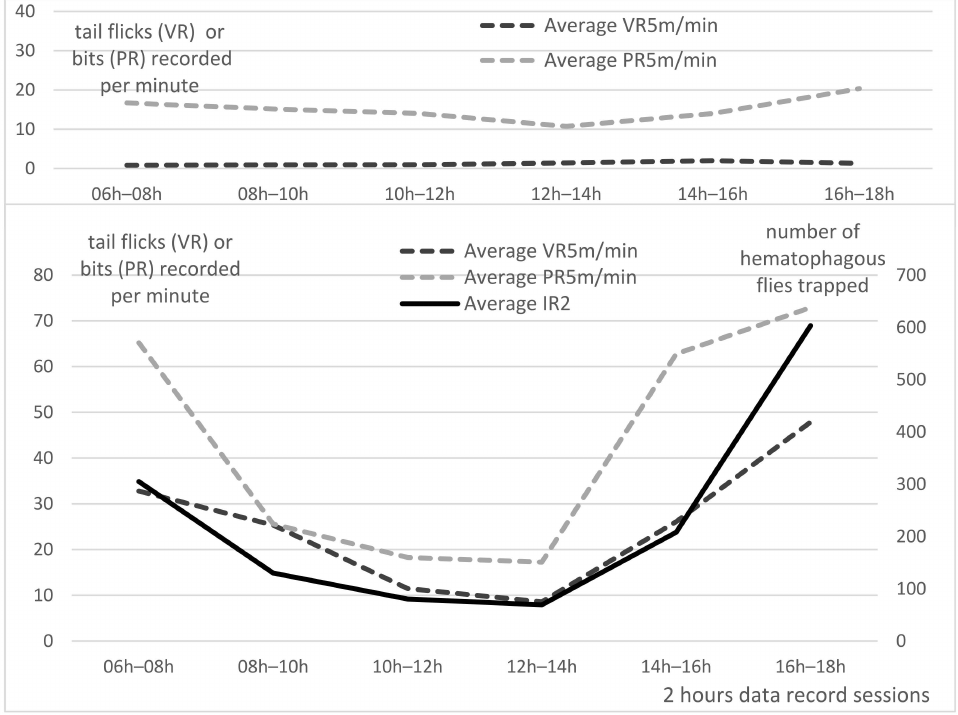
average, 1.2 +/ − 0.8 tail flick/min; however, tail pedometers (PR5m) recorded more